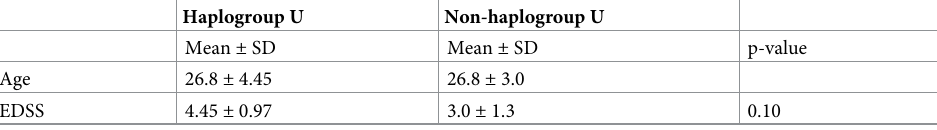
Table 4. Relationship between EDSS and age-matched carriers and non-carriers of haplogroup U.